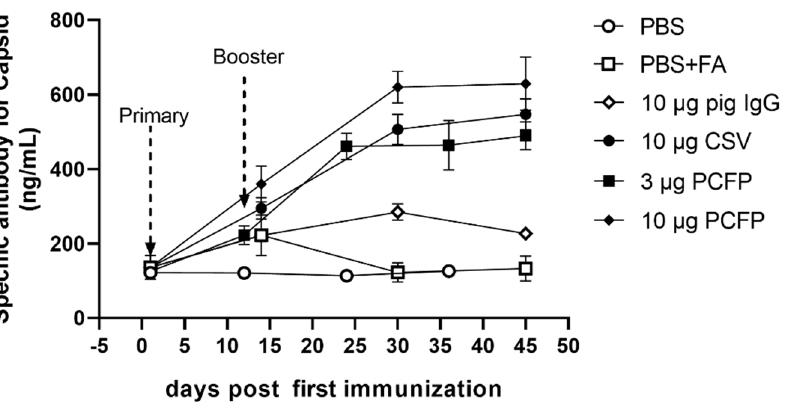
Figure 3. Kinetics of the specific antibody titer for the PCV2 capsid in the serum of BALB/c mice immunized with PCFP. The titer of PCV2b − capsid − specific IgG in serum from immunized mice was measured by ELISA.